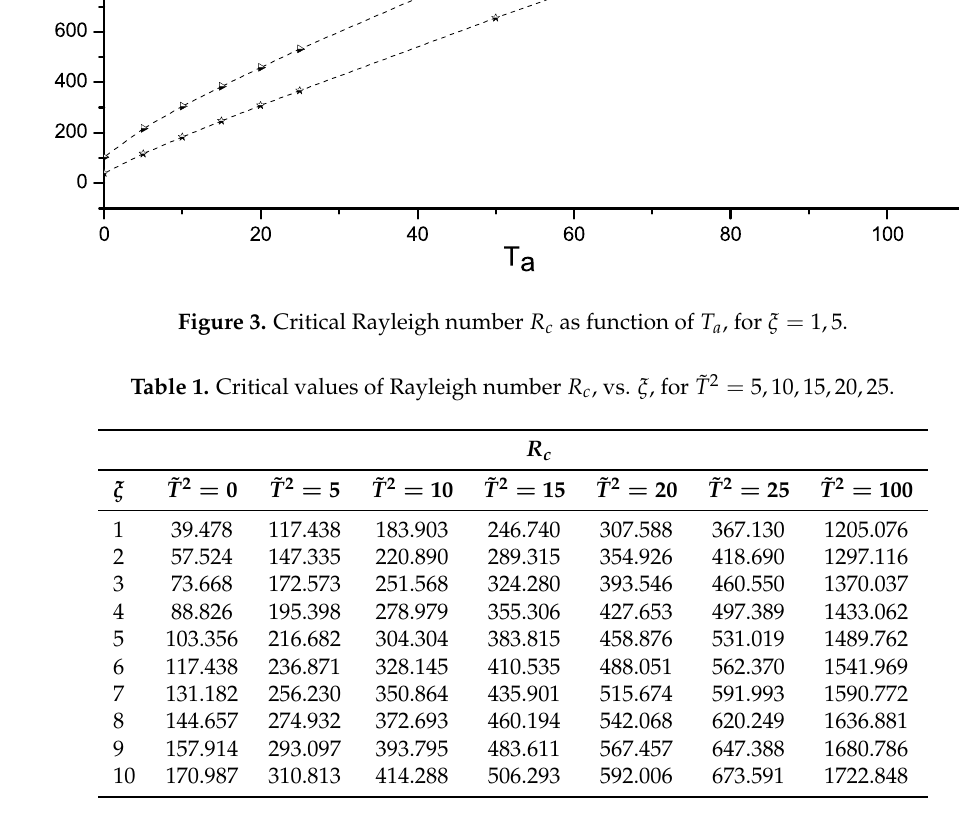
Table 2. Critical values of wave number a c , vs. ξ , for ˜ T 2 = 0,5,10,15,20,25,100.